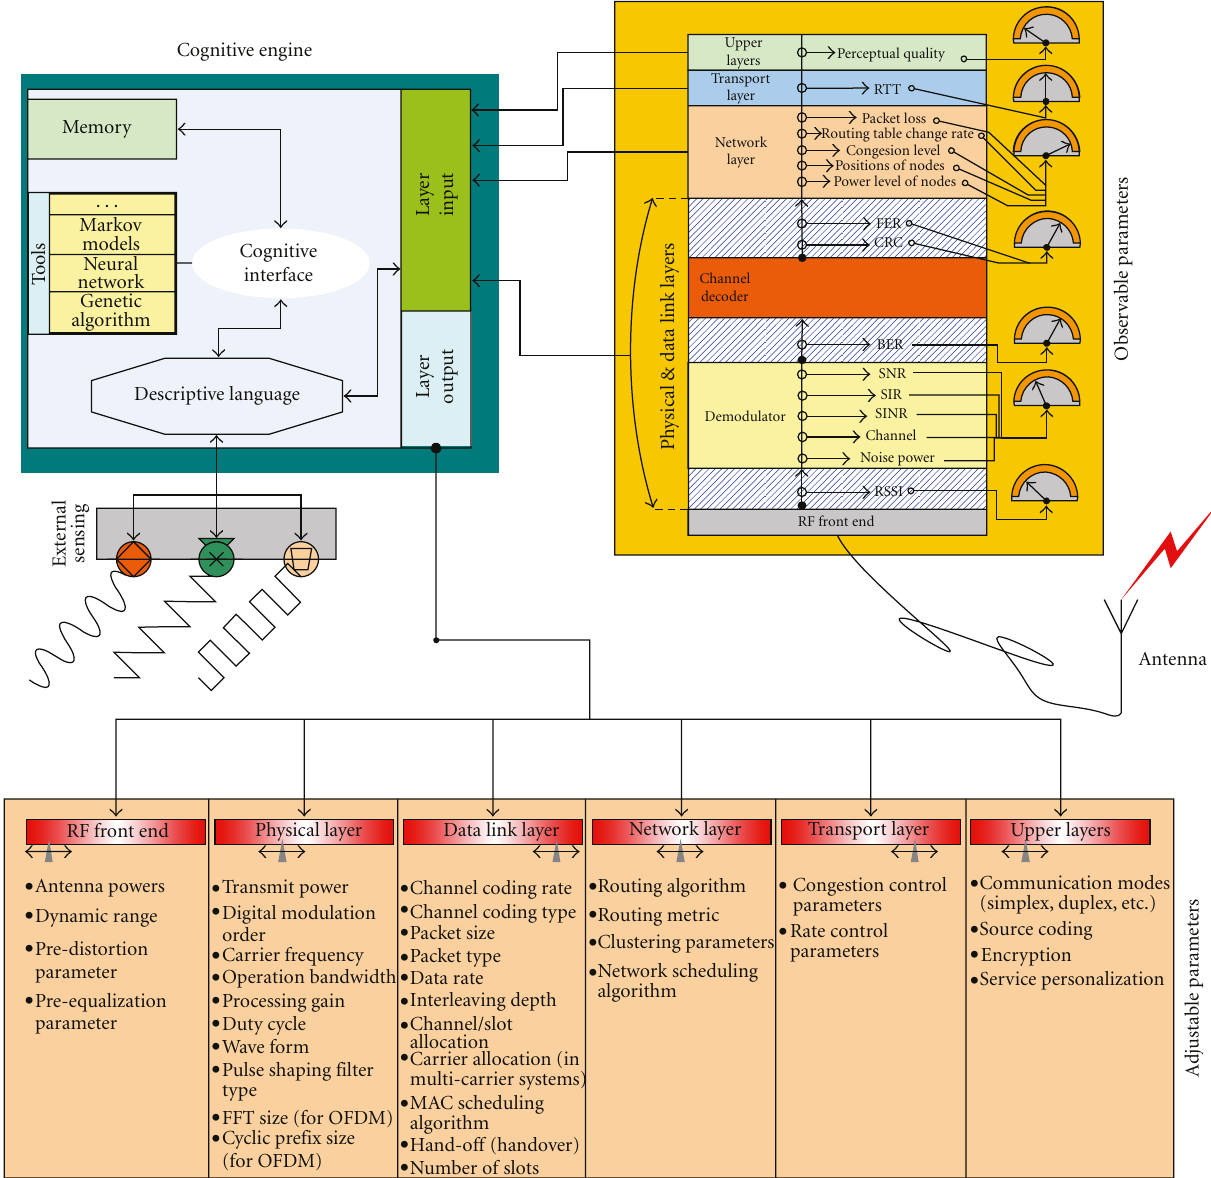
Figure 2: A conceptual model of CR including external sensing capabilities to improve estimations and to attain global adaptation along with observable and adjustable parameters across the protocol